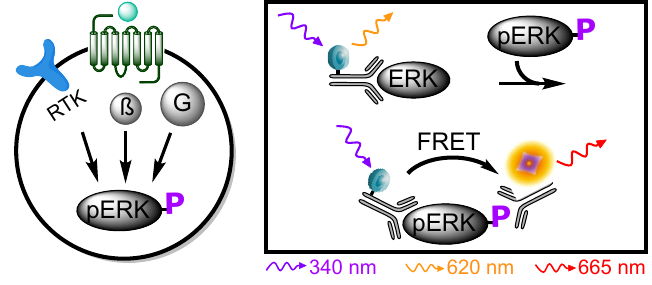
Figure 4. Phospho-ERK assay principle. ( Left ) Upon ligand stimulation of the GPCR various pathways can be activated and lead to the phosphorylation of ERK1/2. Activation can occur by involvement of G proteins (G), via an interaction with β -arrestins ( β ) or transactivation of receptor tyrosine kinases (RTK); ( Right ) A donor-labeled antibody binds ERK1/2 whereas an acceptor-labeled antibody binds phosphorylated ERK1/2 (pERK) giving rise to a FRET